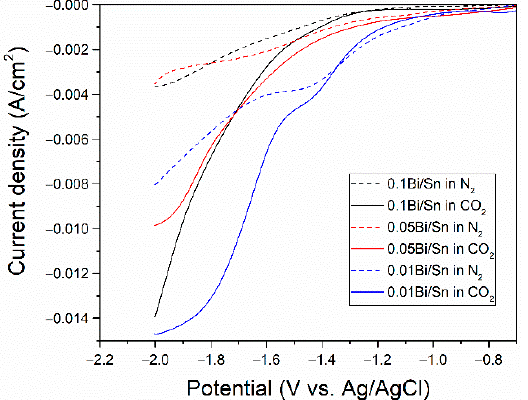
Figure 3. Linear sweep voltammetry (LSV) curves of the Bi/Sn electrodes in N 2 (dashed line) and CO 2 -saturated (solid line) electrolyte.